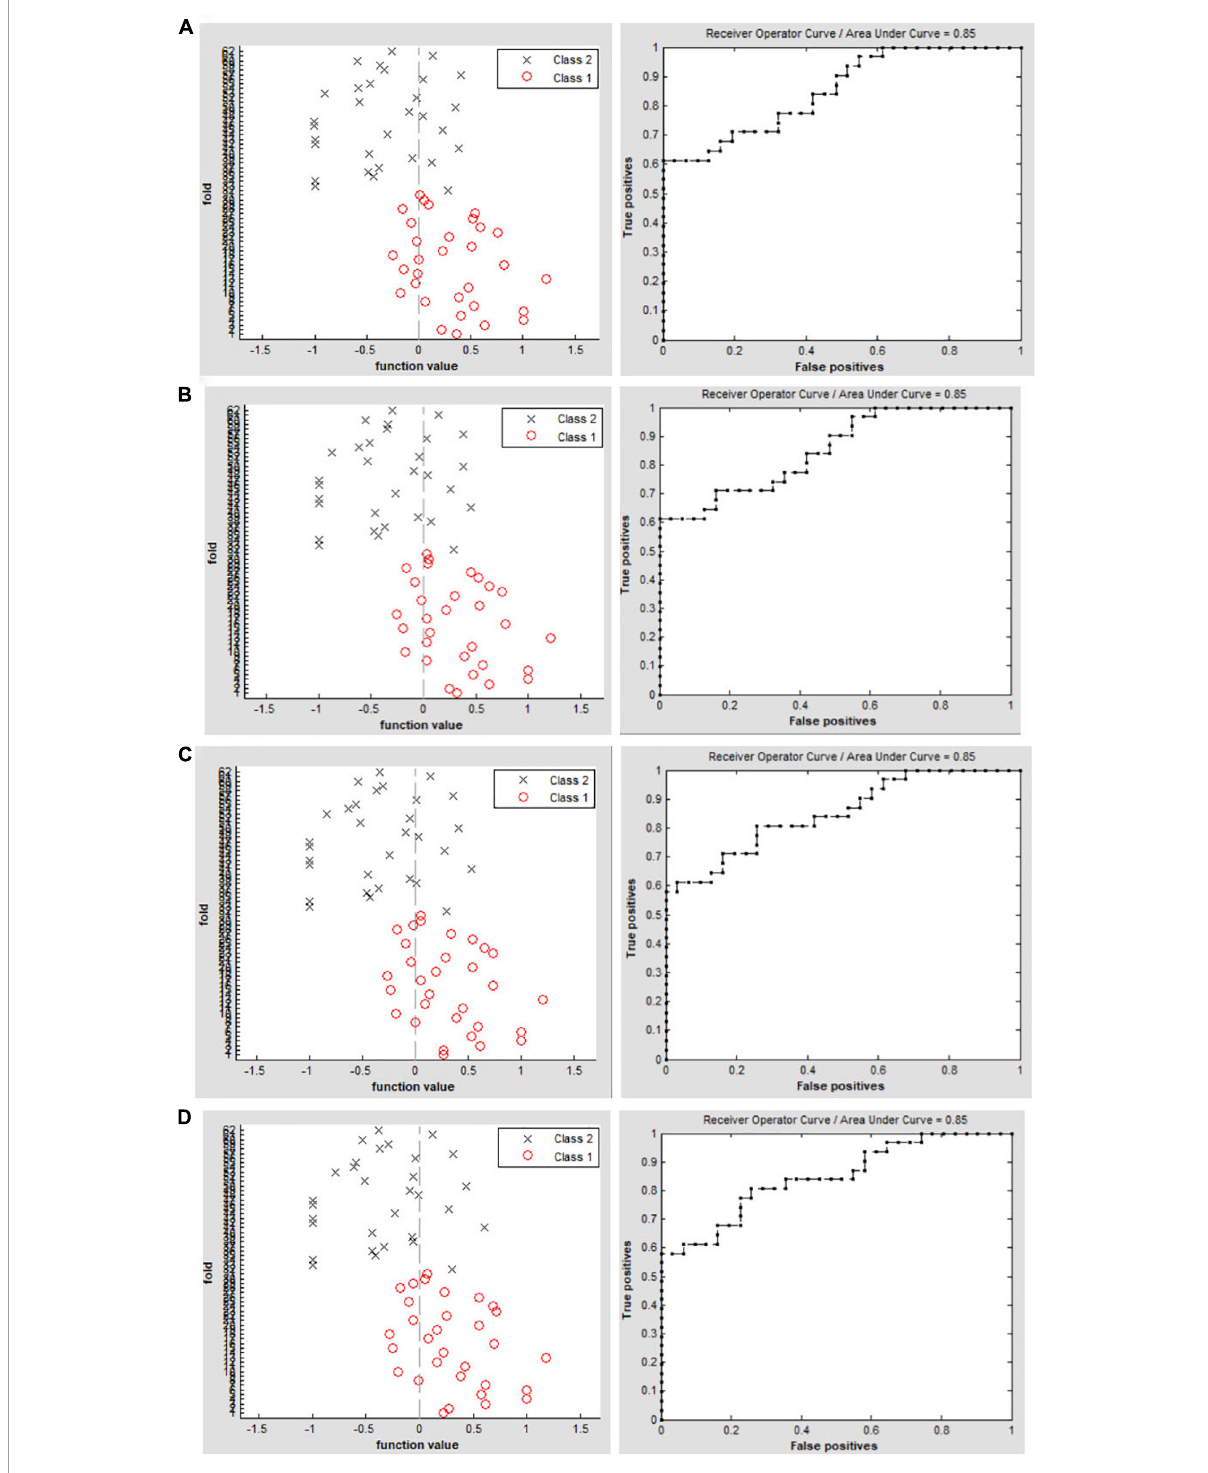
FIGURE3 Classification results using machine learning analysis based on DC values. Function values of two groups (class 1: PACG group; class 2: HC group); The ROC curve of the SVM classifier with an AUC value of 0.85 ( r = 0.15). (A) Function values of two groups (class 1: PACG group; class 2: HC group); the ROC curve of the SVM classifier with an AUC value of 0.85 ( r = 0.20). (B) Function values of two groups (class 1: PACG group; class 2: HC group); The ROC curve of the SVM classifier with an AUC value of 0.85 ( r = 0.25). (C) Function values of two groups (class 1: PACG group; class 2: HC group); The ROC curve of the SVM classifier with an AUC value of 0.85 ( r = 0.30) (D)